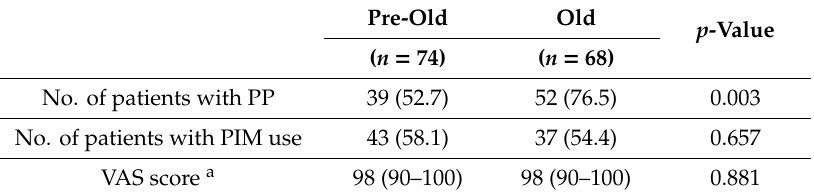
Table 2. Comparisons of PP, PIM use, and VAS between pre-old and old group ( n = 142). Pre-Old Old p -Value ( n = 74) ( n = 68) No. of patients with